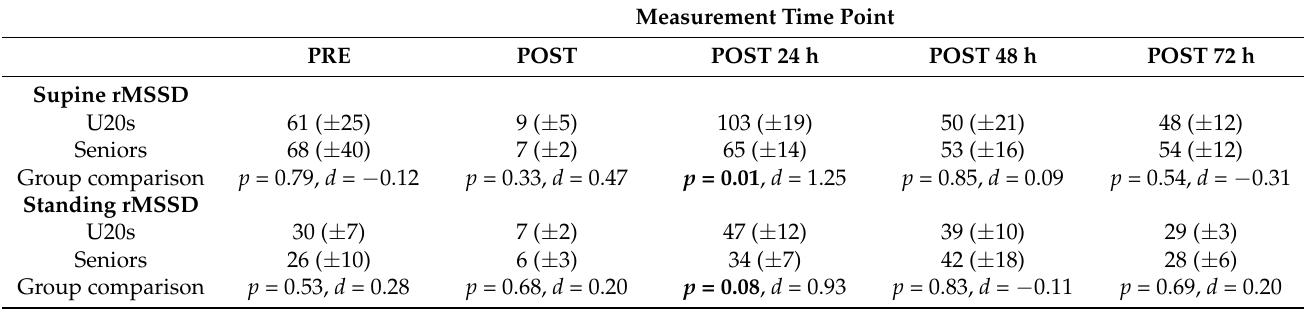
Table 3. Mean RMSSD values (and standard deviations) in the supine and in the standing position [in ms] as a function of age (U20 and senior handball players) for the five different measurement time points (PRE, POST, POST 24 h, POST 48 h, POST 72 h). Statistical values ( p -values and Cohen’s d ) are indicated for group differences between U20 and senior handball